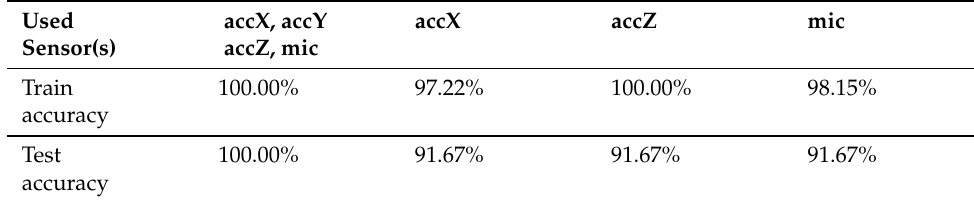
Table 5. Accuracy of the hybrid LSTM model (two LSTM layers).